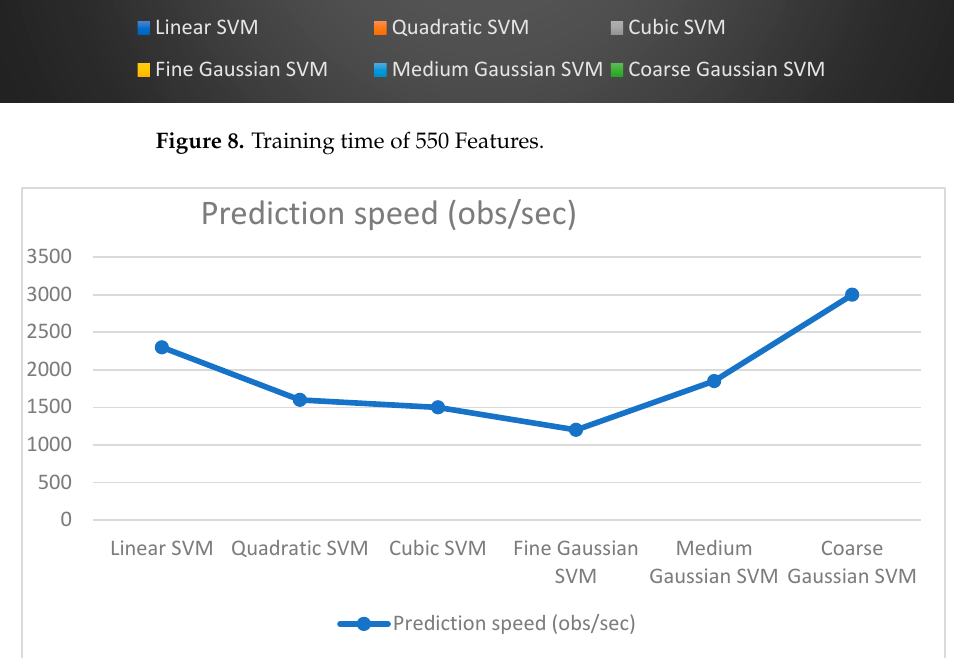
Figure 9. Prediction speed of 550 features.